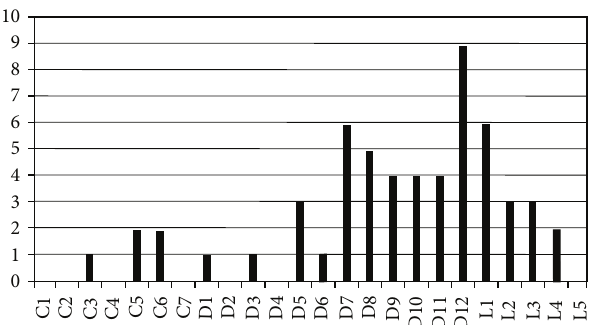
Figure 2: Frequency of vertebral fractures at different vertebral levels. Analysis of 57 newly diagnosed MM patients followed at the Hematology Unit, Rimini Hospital,